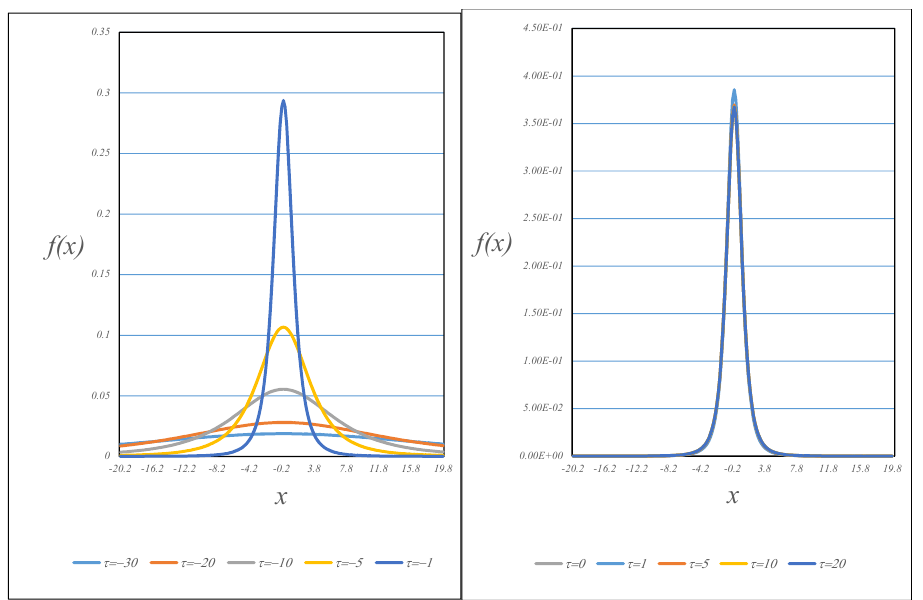
Figure 6. Extended skew-Student density functions, ν = 3, λ = 0.